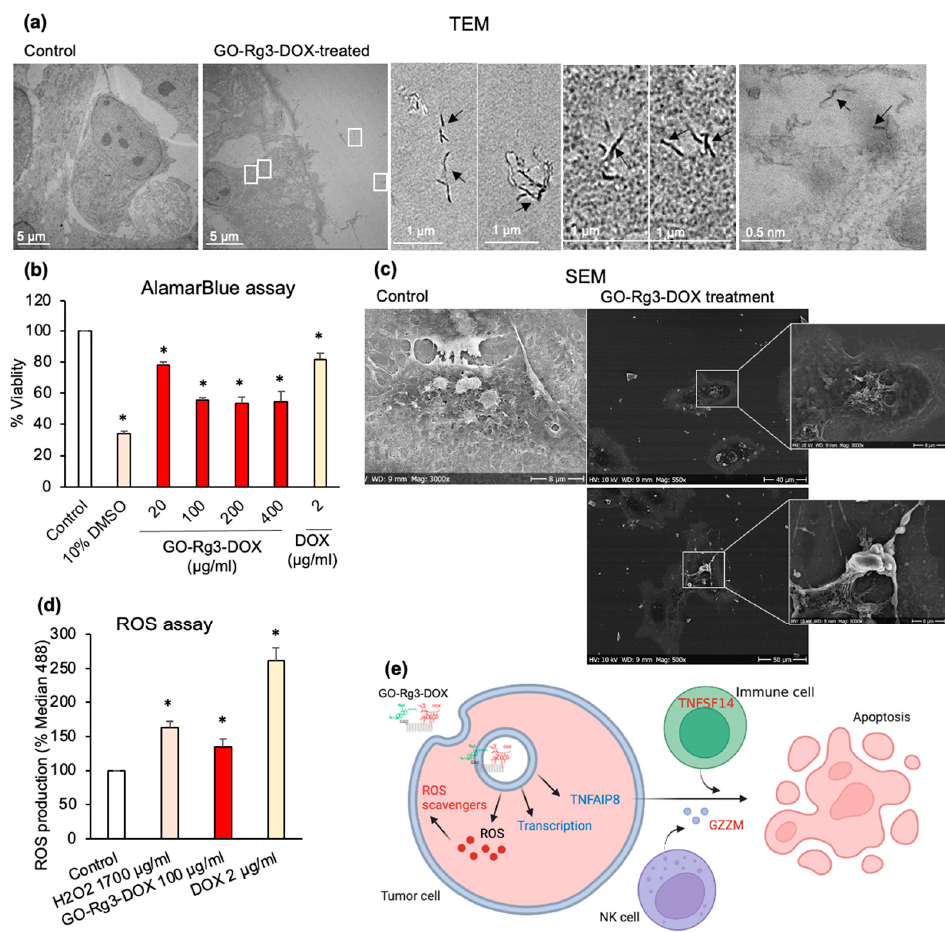
Figure 5. Cytotoxicity of GO–Rg3–DOX against Huh7 cells. ( a ) TEM images of Huh7 cells treated with 100 μ g/mL GO–Rg3–DOX for 6 h compared to untreated cells. Evidence of extracellular GO and GO internalization are marked with white boxes, with higher magnification images and black arrows pointing to GO flakes. ( b ) AlamarBlue cell viability assay 24 h after administration of different concentrations of GO–Rg3–DOX. All values were normalized to those obtained from untreated cells (medium only). The positive controls were 10% DMSO and 2 μ g/mL DOX. ( c ) SEM images of Huh7 cells treated with GO–Rg3–DOX (400 μ g/mL) for 24 h, compared to untreated cells as control. ( d ) ROS production induced by GO–Rg3–DOX 24 h after administration, measured at excitation at 488 nm on a flow cytometer based on the formation of the fluorescent compound 2 ′ ,7 ′ -dichlorofluo- rescein (DCF) in presence of ROS. Median 488 values represent DCF fluorescent signal and are